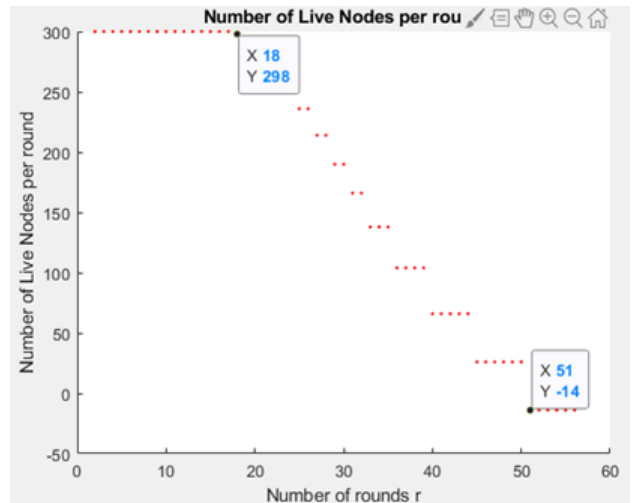
Figure 36. Number of live nodes per round r without the LEACH algorithm (i.e., conventional NB-IoT).